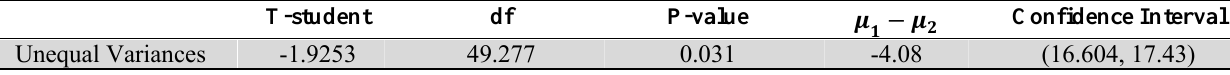
T-student df P-value (cid:2246)